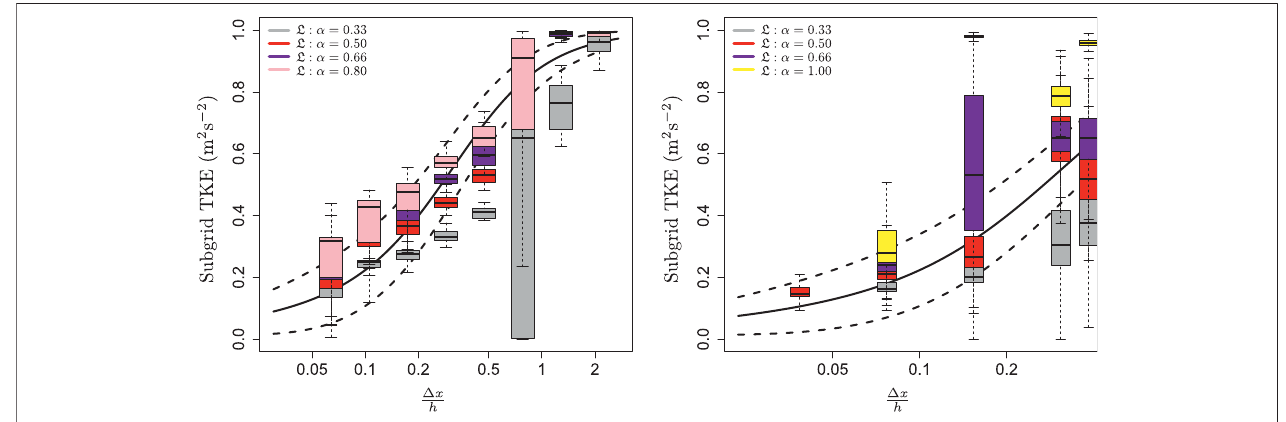
FIGURE8| Sensitivitytesttothe α from0.33to1inIHOP (left) andMUST (right) .ThesubgridTKEisrepresentedasafunctionoftheresolutionnormalizedbythe ABL height. The reference partial similarity function for the TKE (Honnert et al., 2011) and the uncertainty margins are represented by the full and dashed black lines, respectively.